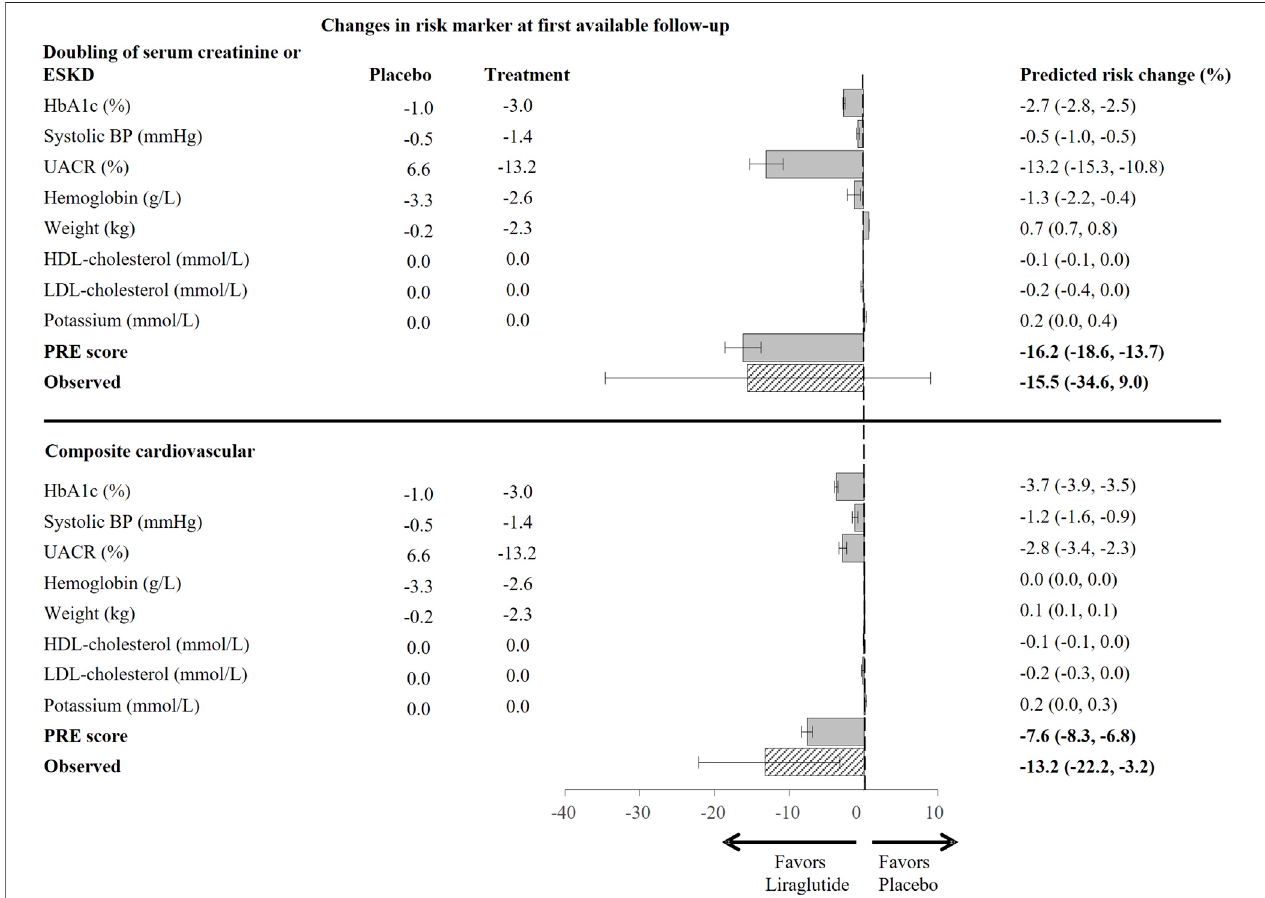
FIGURE 2 | Predicted risk change for the composite kidney (doubling of serum creatinine or ESKD) and the composite cardiovascular (non-fatal myocardial infarction, non-fatal stroke, or cardiovascular death) outcome in the total population based on single risk marker as well as the PRE score, using risk markers changes from baseline to 6-months or fi rst available follow up (N = 9,340). Bars indicate estimates of the mean change in relative risk for speci fi c outcomes with 95% con fi dence intervals,ascomparedtoplacebo.HbA1c,glycatedhemoglobin;BP,bloodpressure;UACR,urinary-albumin-creatinine-ratio;HDL,high-density-lipoprotein;LDL, low-density-lipoprotein; PRE score, Parameter Response Ef fi cacy score; ESKD, end stage kidney